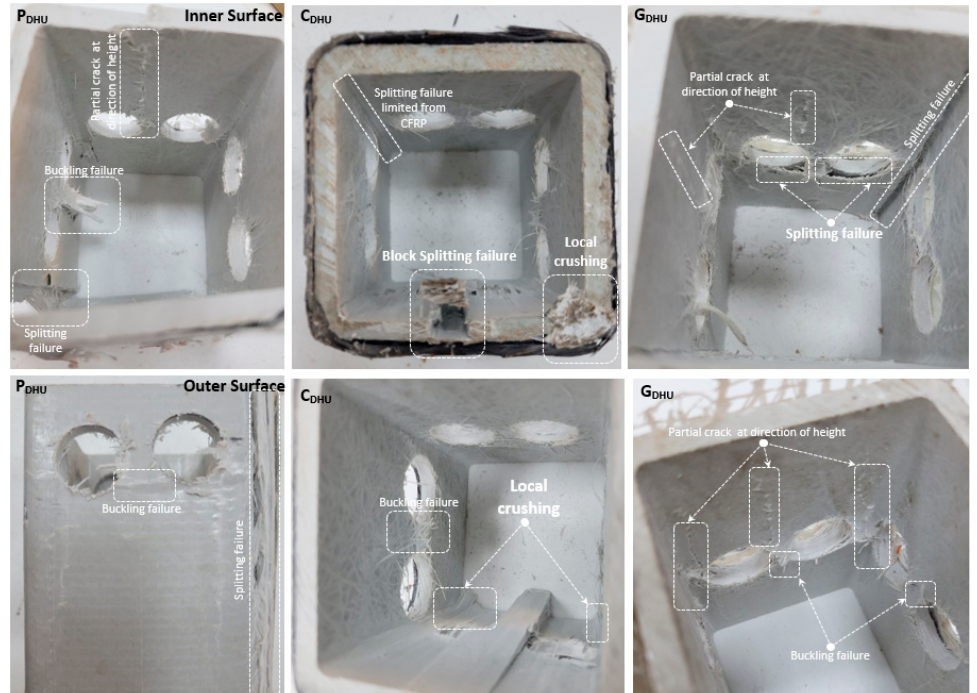
Figure 9. Damage analyses of P DHU , C DHU , and G DHU .